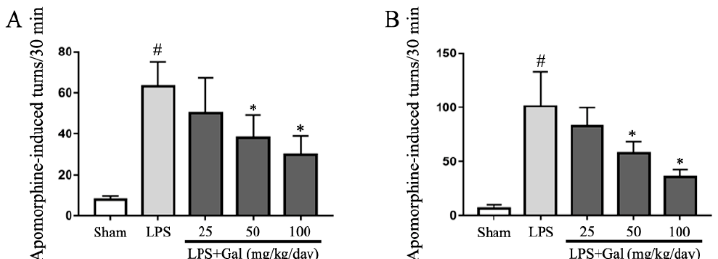
Figure 3. Galangin attenuated LPS-induced motor dysfunction in rat. ( A , B ) The number of turns at 14 days ( A ) and 28 days ( B ) was induced by apomorphine in an LPS-induced PD rat model ( n = 12 per group). Data are shown as means ± SD. # p < 0.05 compared to the sham group, * p < 0.05 compared to the LPS